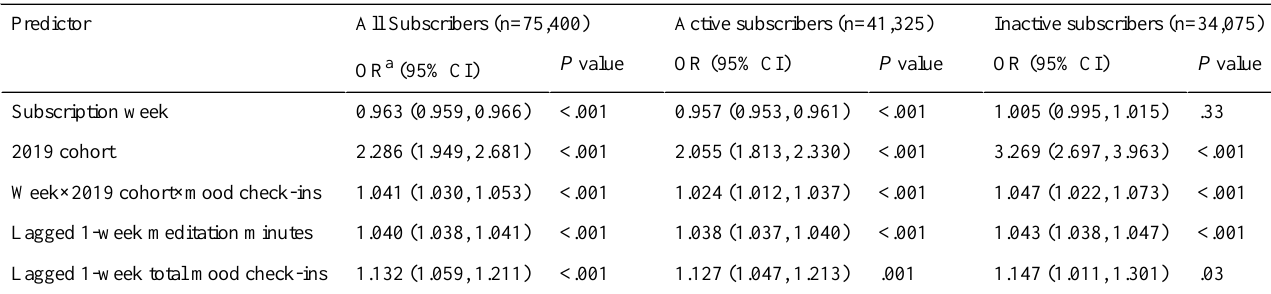
Table 4. Effect (logistic panel regression estimates) of past mood check-ins on the likelihood of weekly